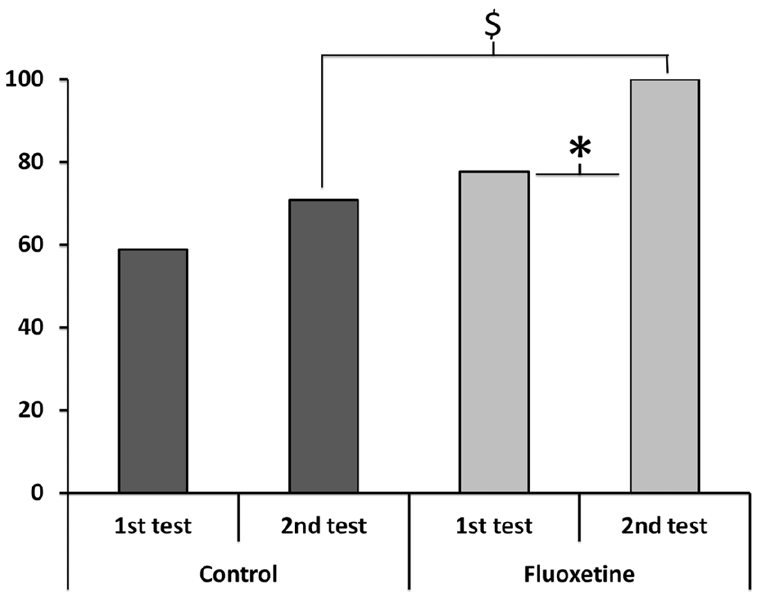
Figure 3. Percents of successful grip tests (suspension time $ 30 sec) in dark grey for the mice treated with fluoxetine and light grey for the controls. Grip tests were performed in each group to quantify forelimb involvement 15 and 30 min after surfacing. $ denotes p , 0.05 between the groups and *denotes p , 0.05 between the paired mice.